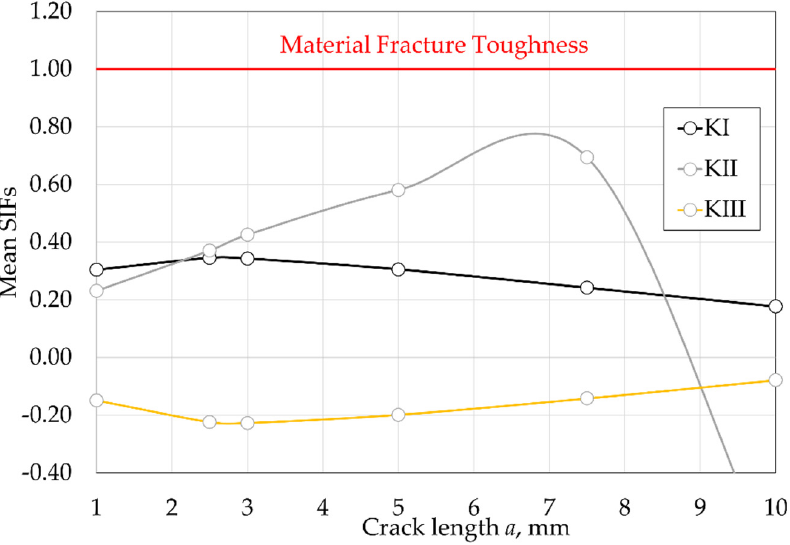
Figure 23. Evolution of the SIFs with the crack length a at the PETE of the vane compared and normalized with the material fracture toughness